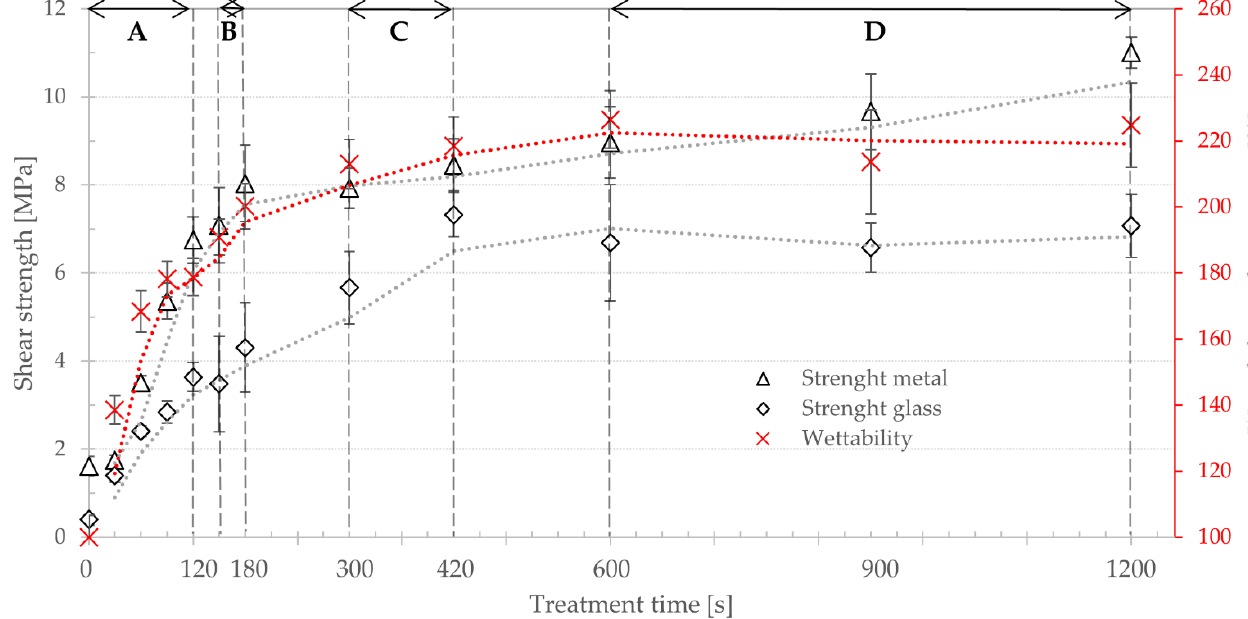
Figure 9. Correlation between wettability enhancement, shear strength (metal and glass substrates) and treatment time (linear timeline).